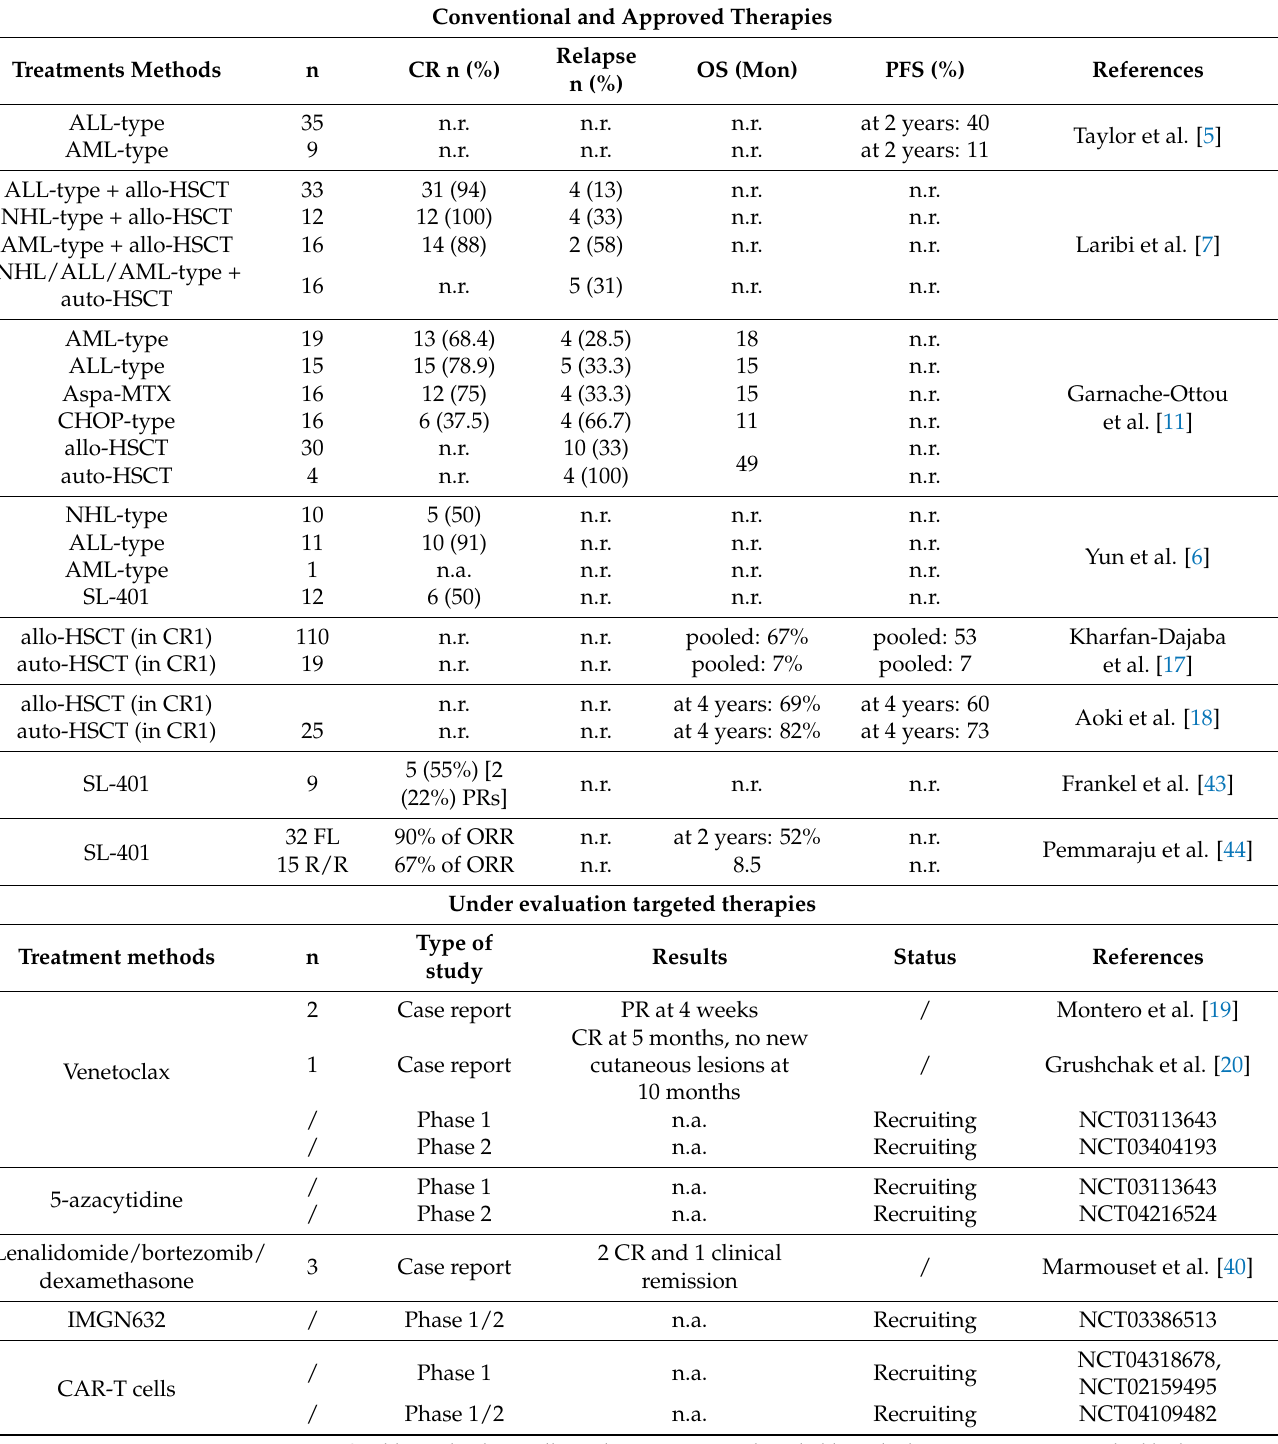
Table 1. Summary of studies and ongoing clinical trials on BPDCN patients evaluating conventional and targeted